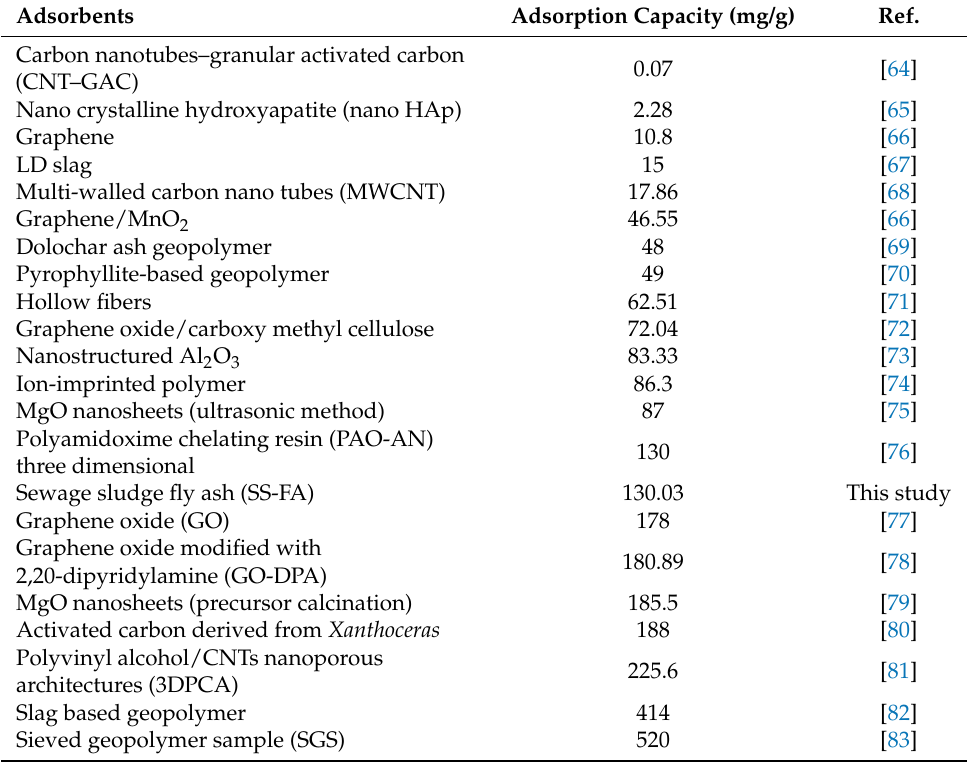
Table 5. Comparison of maximum adsorption capacity of SS-FA with different adsorbents.